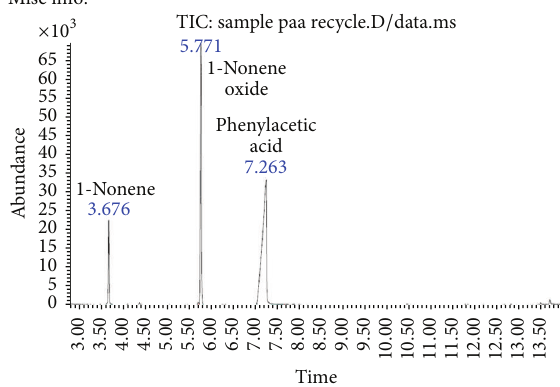
Figure 1: The GC chromatogram of epoxidation of 1-nonene using recycled phenylacetic